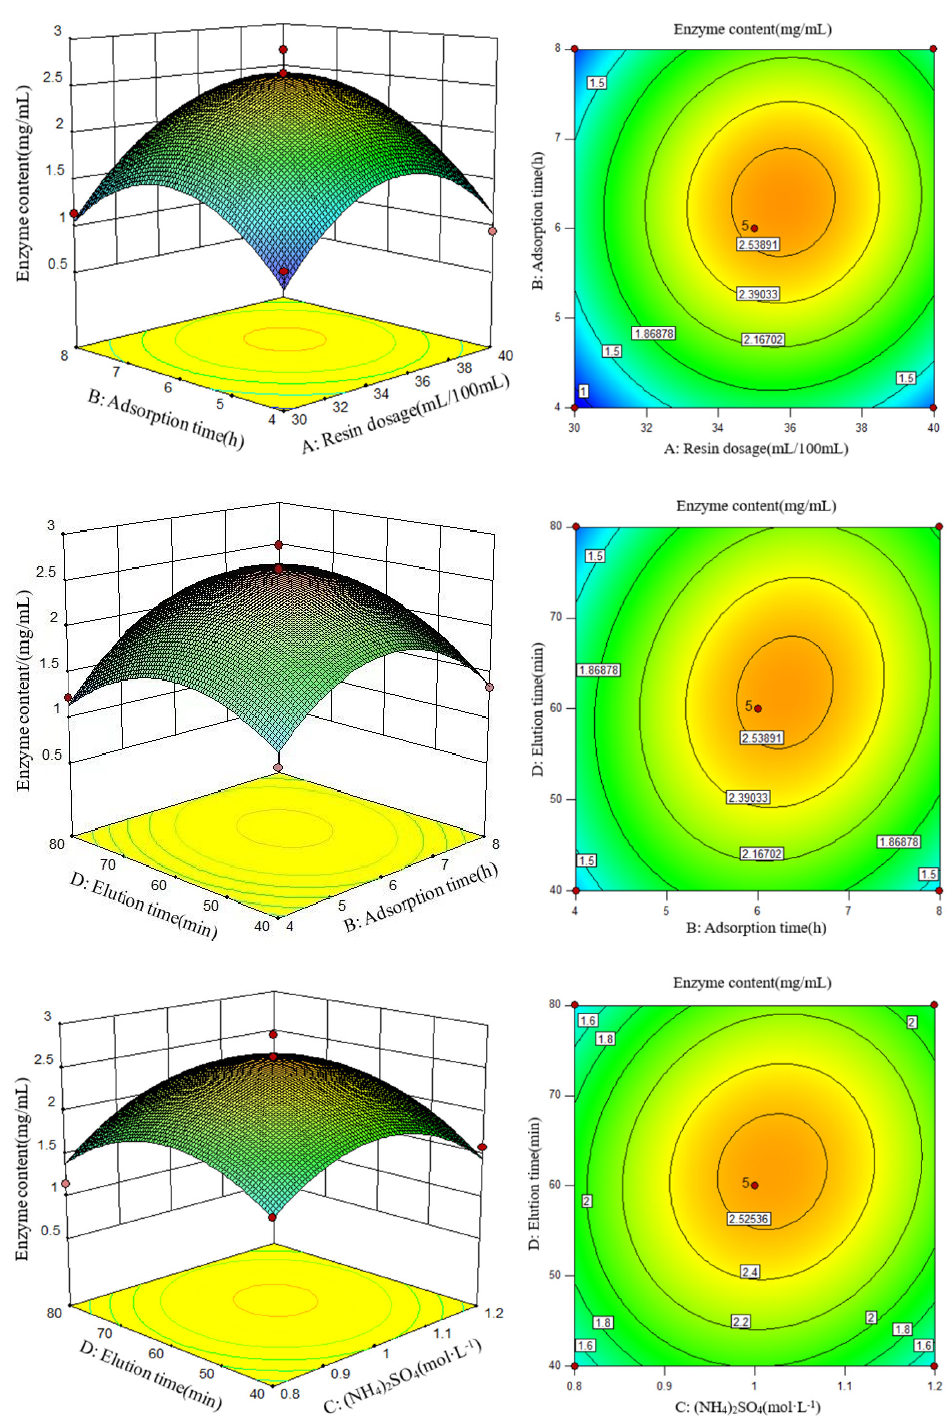
Figure 3. Response surface and contour plots for the effects of ( A ) resin dosage, ( B ) adsorption time, ( C ) ammonium sulfate concentration, and ( D ) elution time on the content of lysozyme obtained from SDEW.